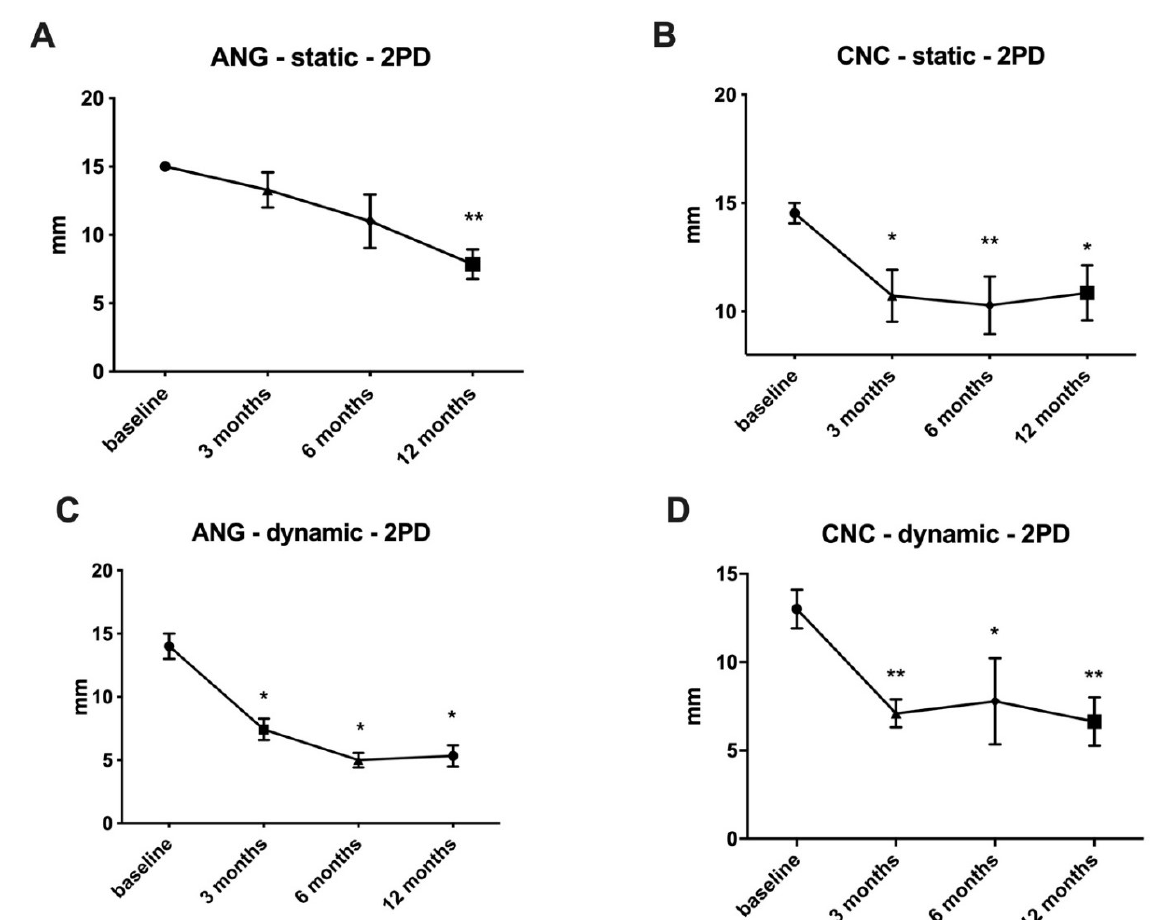
Figure 3. Two-point discrimination for ANG and CNC after three, six, and twelve months. Static two-point discrimination showed the first significant recovery compared to baseline after twelve months for the ANG group ( A ; p < 0.01). In contrast, CNC presented the first significant recovery compared to the baseline after three months ( B ; p < 0.05). Dynamic two-point discrimination revealed slightly superior results compared to static two-point discrimination, with the first significant results for ANG ( C ; p < 0.05) and CNC ( D ; p < 0.01) after three months. ANG: autologous nerve graft; CNC: chitosan nerve conduit; * p < 0.05, ** p < 0.01.